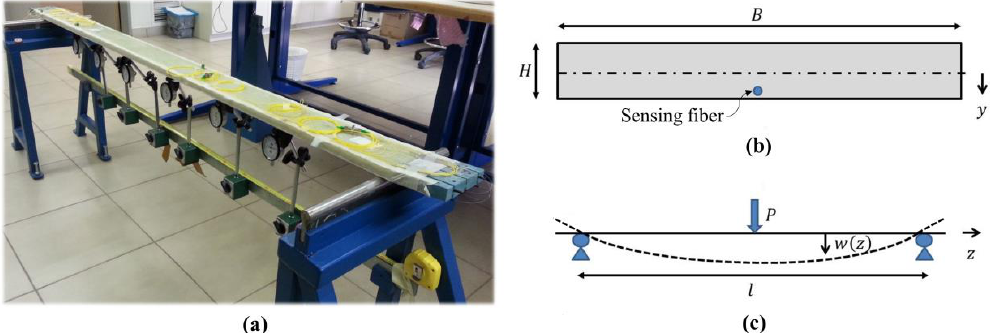
Figure 3. ( a ): A composite beam with embedded sensing fibers, placed in a three-point bending setup. The setup is equipped with six mechanical deflection indicators [42]. ( b ): Schematic illustration of the beam cross-section, showing the location of the sensing fiber. ( c ): An illustration of the bending configuration, with definition of the coordinate system used.